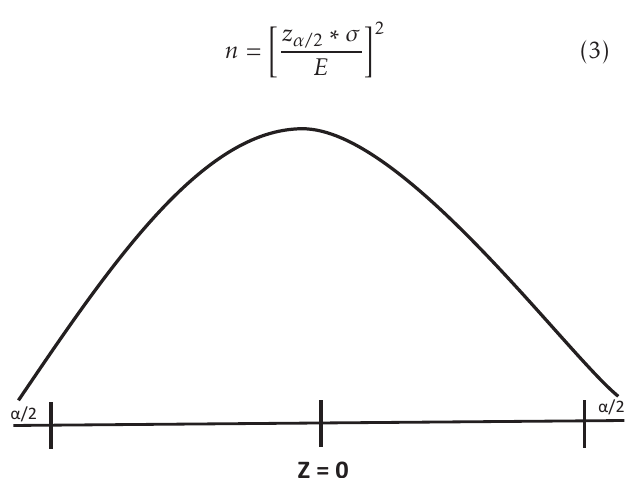
Figure 5. Critical value of the Standard Normal